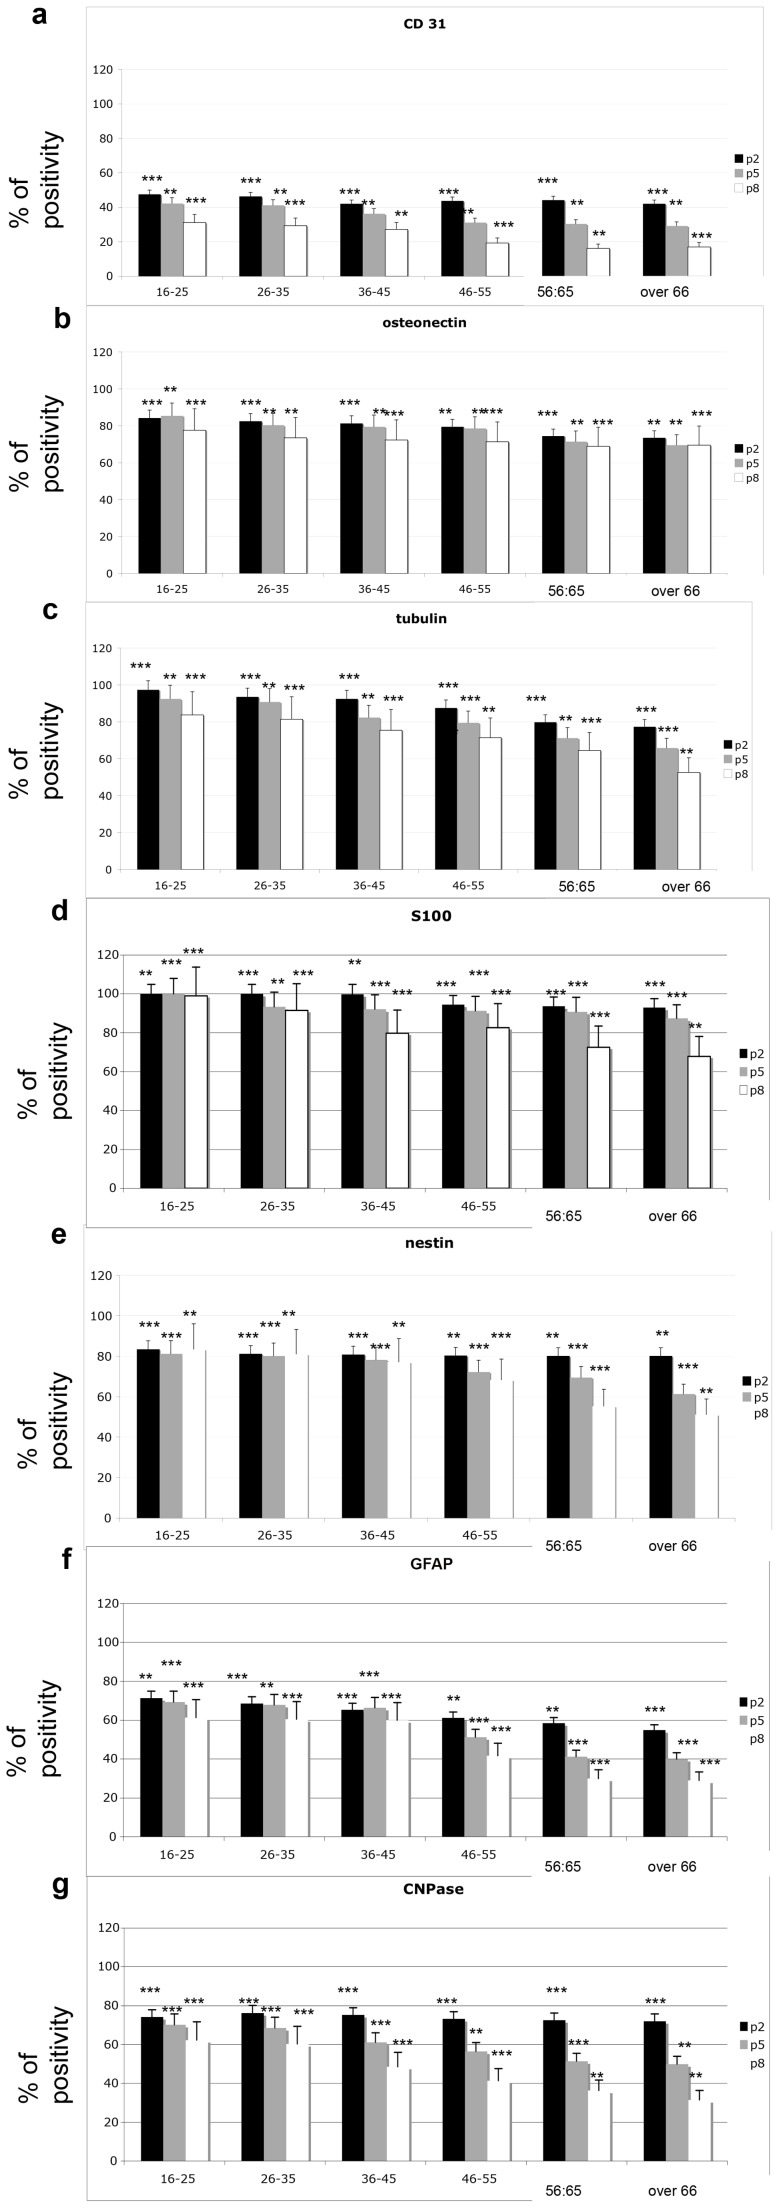
Quantitative analyses of lineage commitment were performed by analyzing the percent of positive cells for each marker.The commitment was detected in all donor age and in vitro passage groups. T tests were used to determine significant differences (p<0.05). * p<0,05; * * p<0,01; * * * p<0,001. Repeatability was calculated as the standard deviation of the difference between measurements.